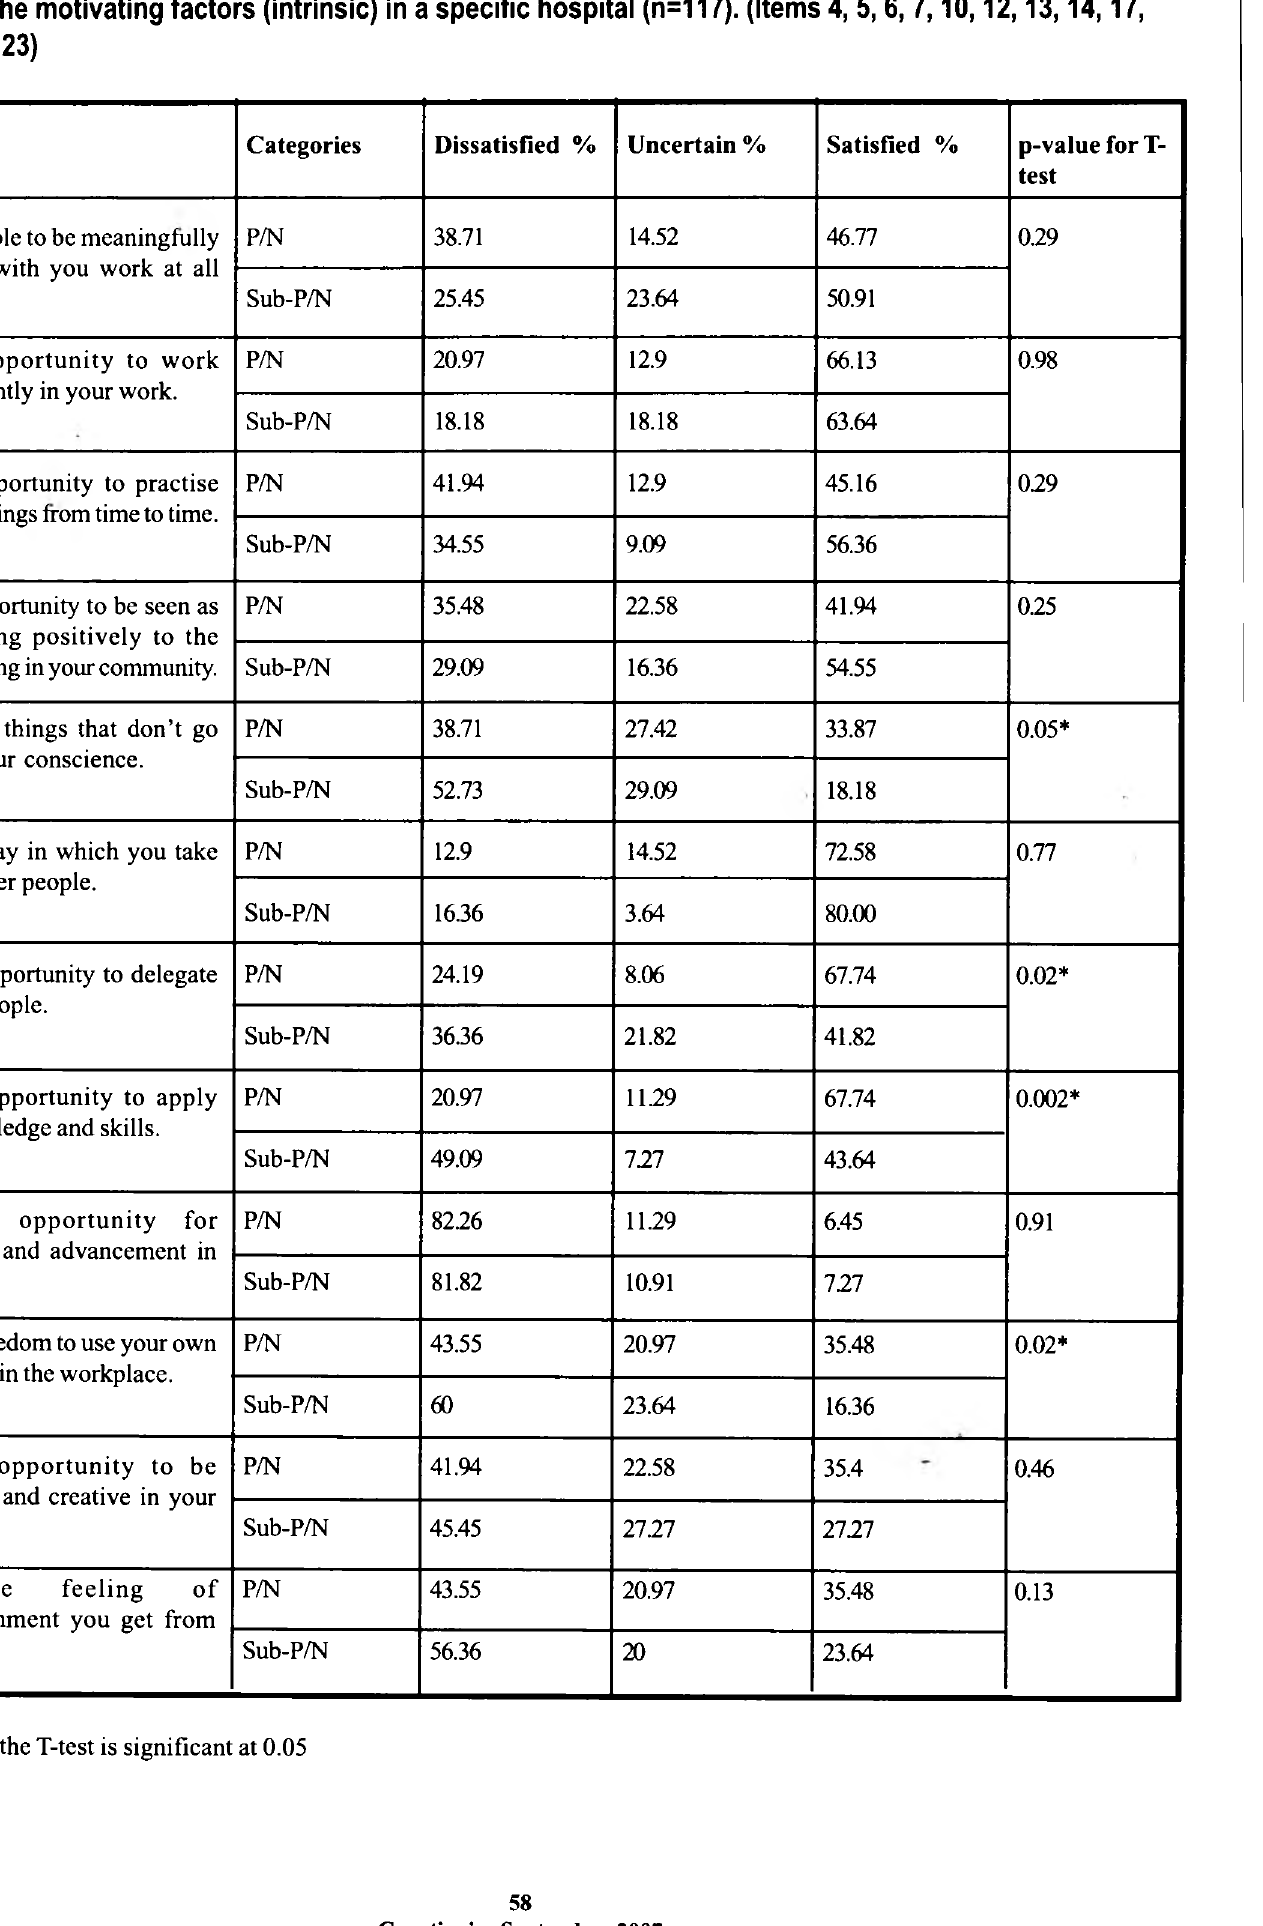
Table 3 : A comparison of satisfaction between Professional (p/n) and Sub-professional (sub. P/n) nurses regarding the motivating factors (intrinsic) in a specific hospital (n=117). (Items 4, 5,6,7,10,12,13,14,17, 18,19, and 23)